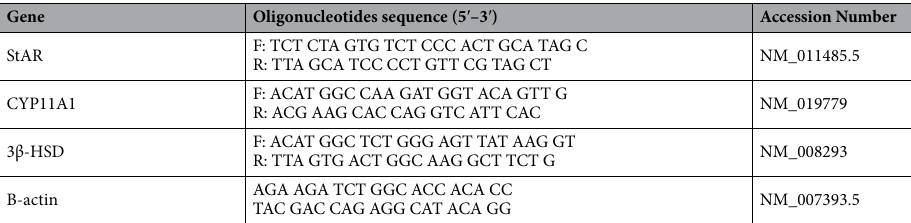
Table 1. Primer sequences for RT-PCR. Abbreviations: F: forward primer; R: reverse primer. StAR: steroidogenic acute regulatory protein; CYP11A1: P450scc-cholesterol side-chain cleavage enzyme; 3β-HSD: 3β-hydroxysteroid